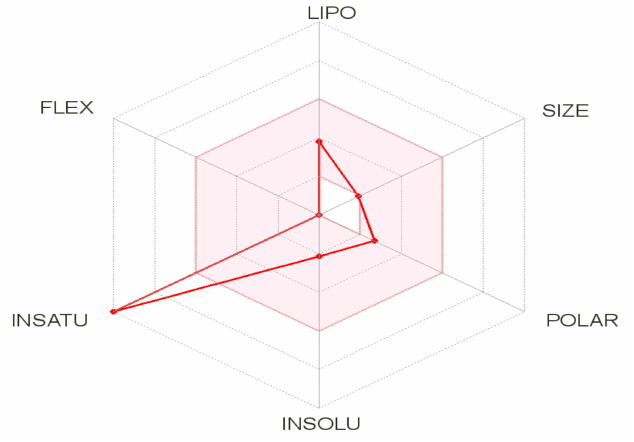
Figure 3. The ADME radar chart of 5-AIQ obtained from SwissADME software.